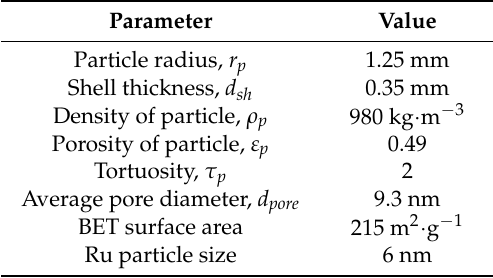
Table 1. Characteristic data of the Ru